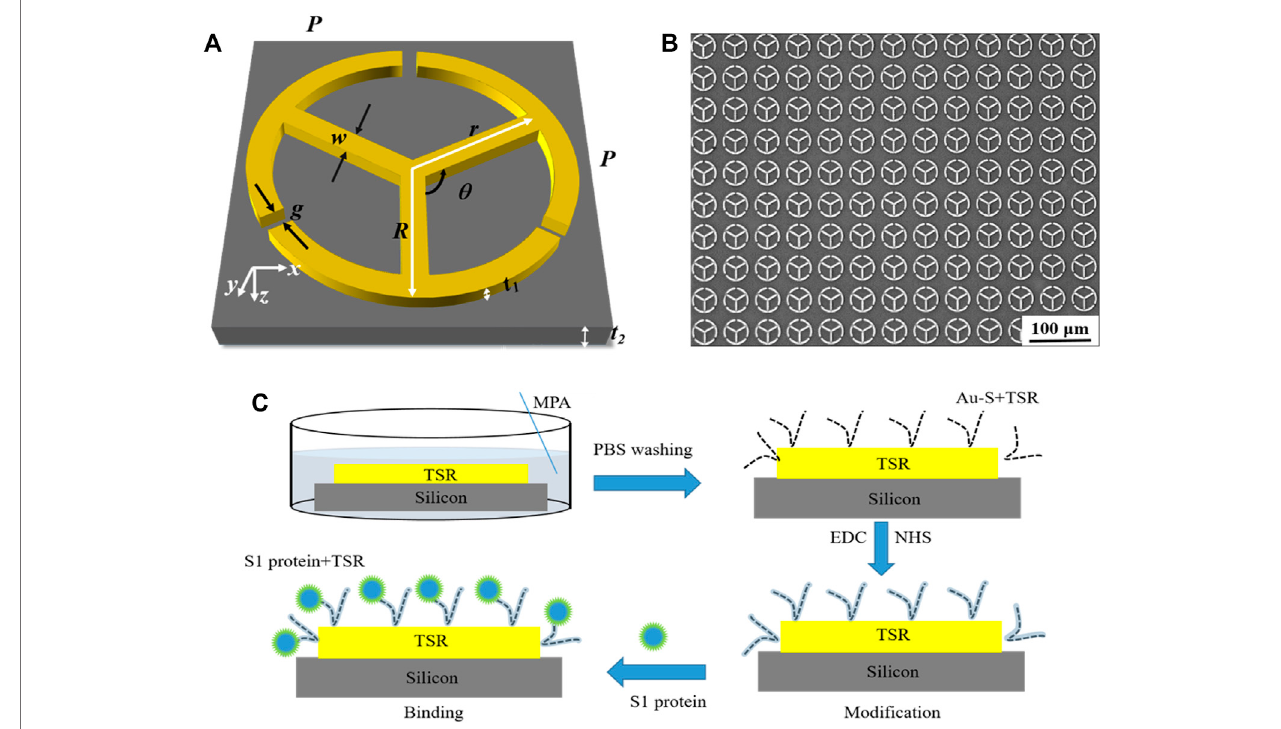
FIGURE 1 | (A) Schematic representation of the proposed TSR resonator. The incident THz wave is polarized along the x axis. (B) Microscope image of the fabricated TSR unit cells. (C) Biological modi fi cation process.